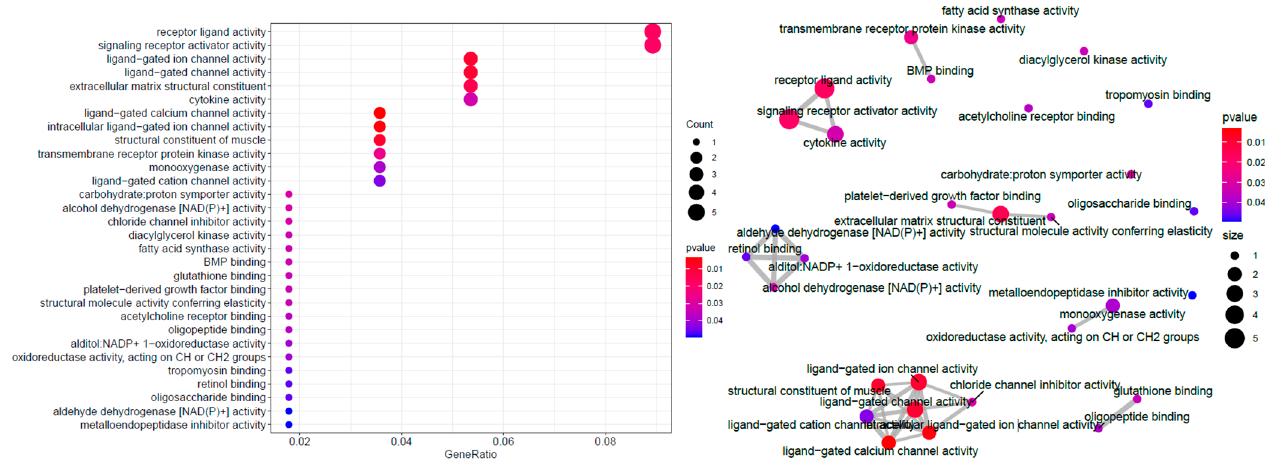
Figure 4. GO and KEGG enrichment of the top 100 methylation sites.